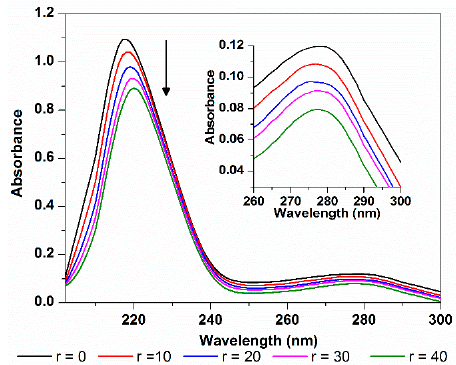
Figure 11. Absorption spectra changes of HSA with the addition of TCPC ( r = [TCPC]/[HSA]) in Buffer IV (pH = 7.4).